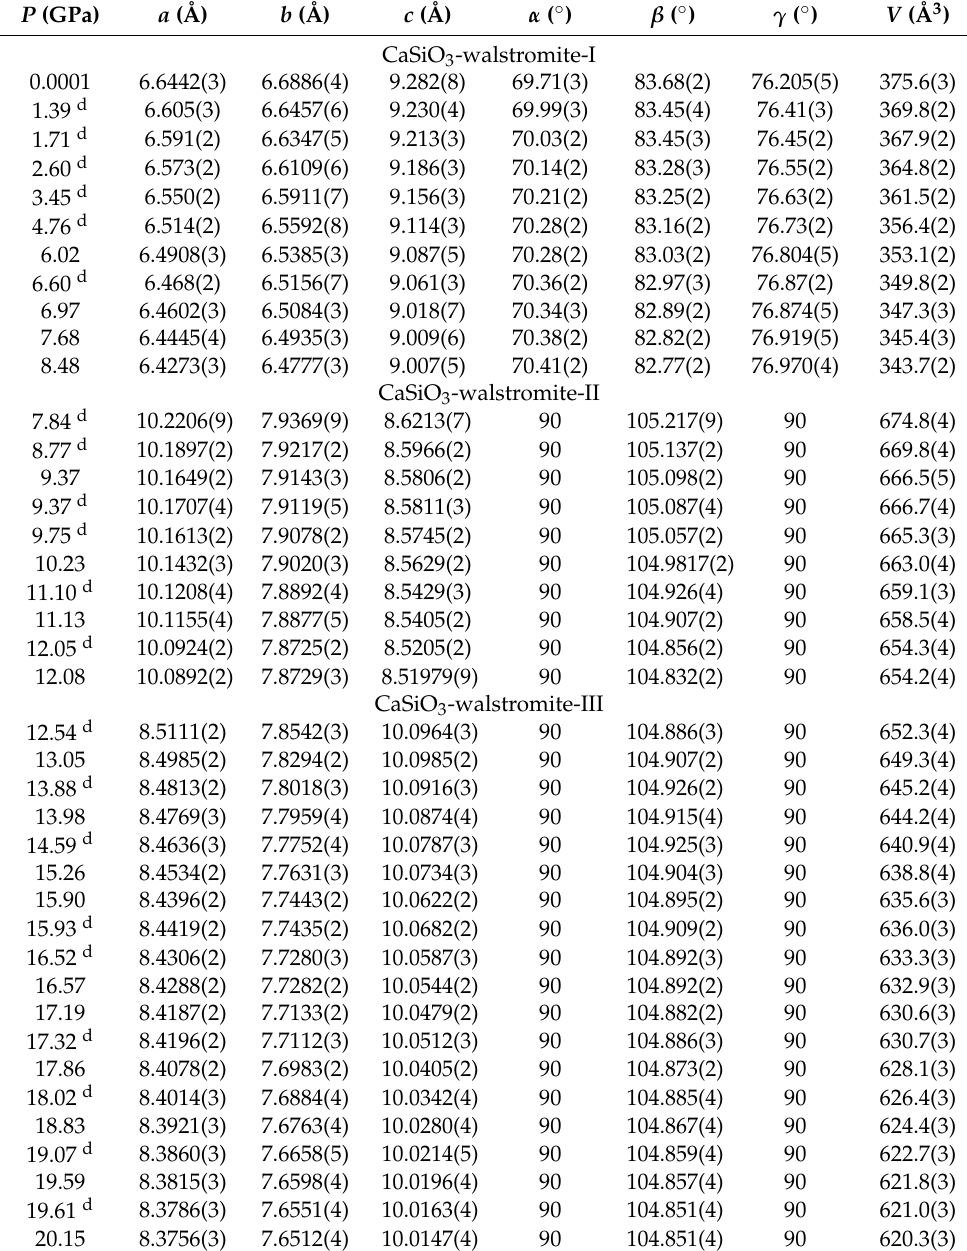
Table 4. Lattice parameters of CaSiO 3 -walstromite at different pressures, collected using helium as P -transmitting medium ( P -uncertainty: ± 0.05